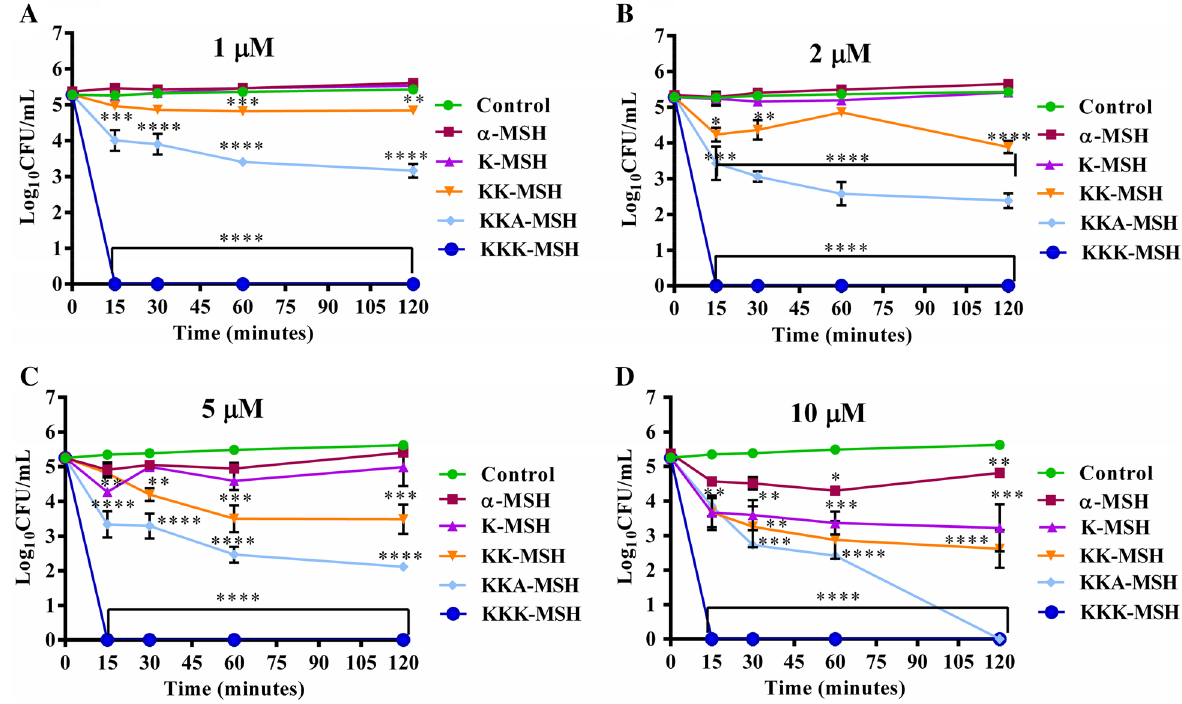
Figure 1. Killing kinetics of α-MSH and its cationic analogues at different concentrations, ( A ) 1 µM, ( B ) 2 µM, ( C ) 5 µM, and ( D ) 10 µM, of peptides against logarithmic phase E. coli ATCC 25922. The graphs were generated from the representative values (average ± SE) of three independent experiments (* P < 0.05, ** P < 0.01, **** P < 0.0001 compared to untreated control).